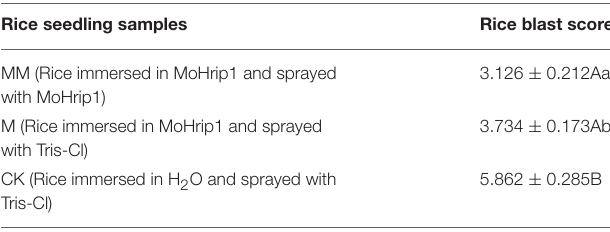
TABLE 3 | Disease severity of rice blast in leaves of MoHrip1-treated and control-treated rice plants. Rice seedling